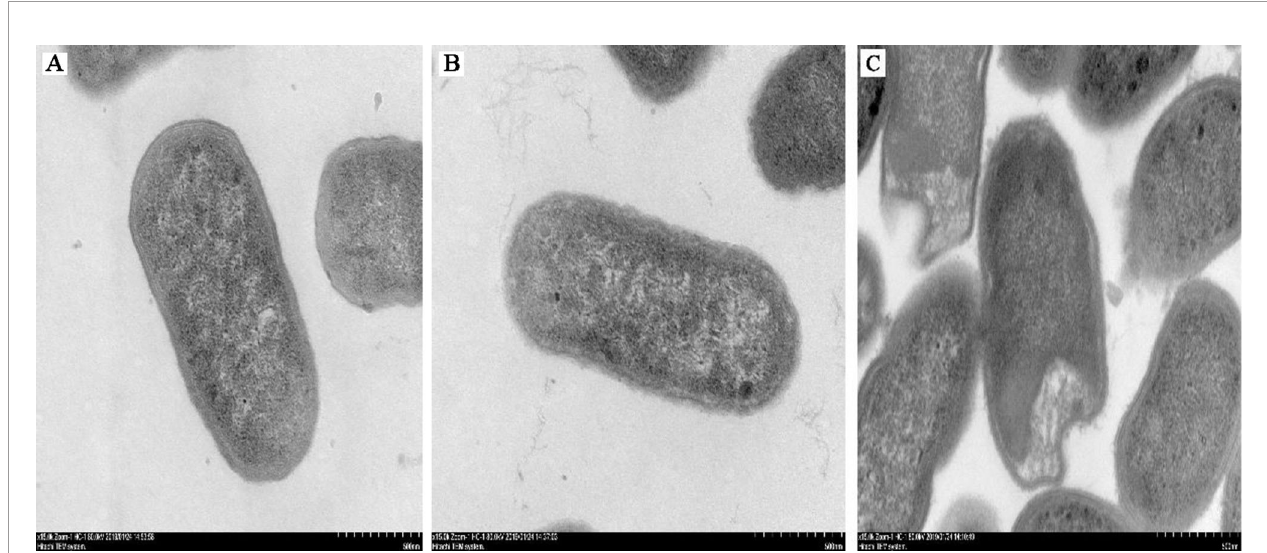
FIGURE 3 | Micrographs of ETEC K88 cells (ultra-thin sections) after treatment. (A) ETEC K88 cells (10 7 CFU/mL) were incubated with sterile PBS (0.1 mol/L, pH 7.4); (B) ETEC K88 cells (10 7 CFU/mL) were incubated with 5 mg/mL of non-speci fi c IgY; (C) ETEC K88 cells (10 7 CFU/mL) were incubated with 5 mg/mL of anti-ETEC